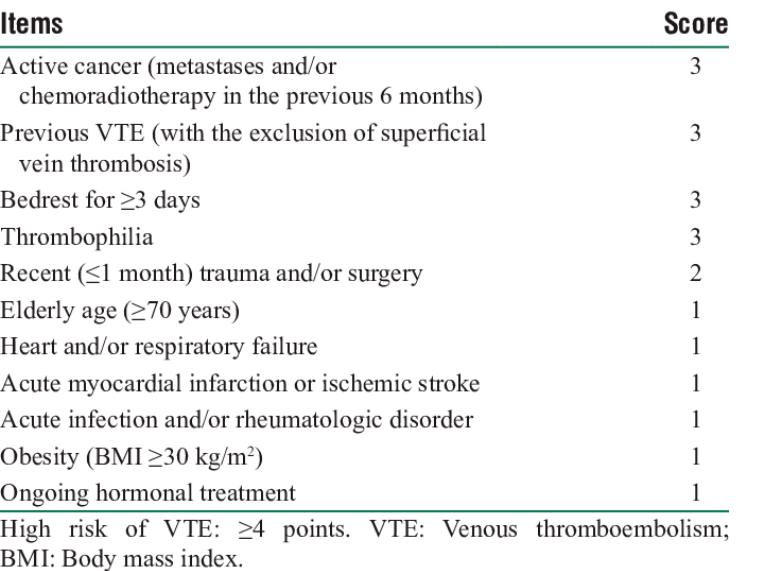
Figure 1. Padua Prediction Score. This picture is imported form the original paper added in reference number